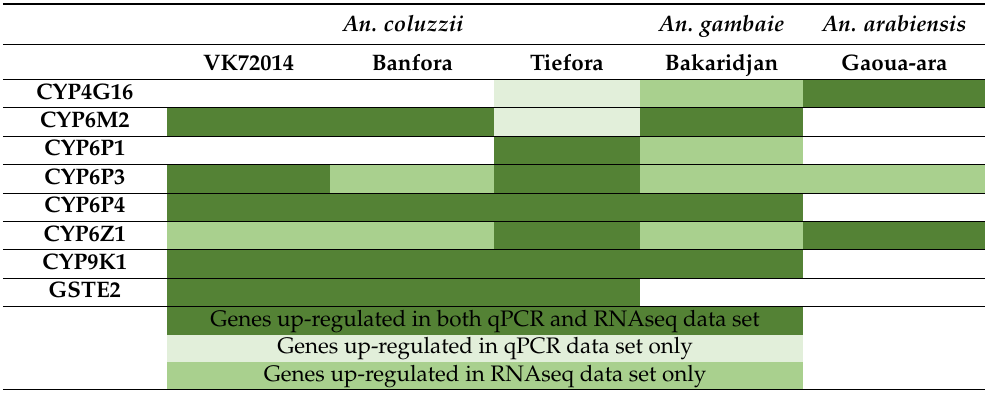
Table 2. Summary of correlation between results of detoxification multiplex qPCR and RNAseq